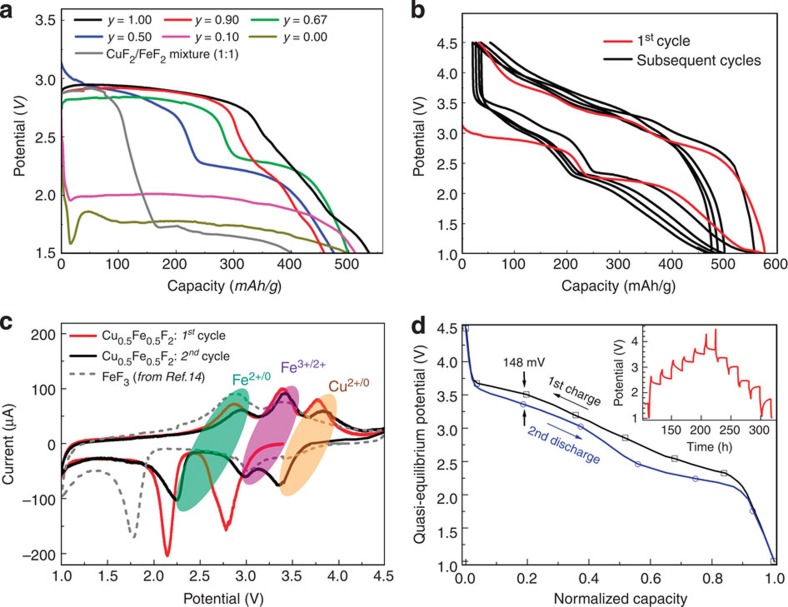
Electrochemical properties of CuyFe1-yF2 solid–solution.(a) Voltage profiles (first discharge at a current 5 mA g−1) of the CuyFe1-yF2 series along with a simple mixture of CuF2 and FeF2 (b) voltage profiles of Cu0.5Fe0.5F2 for the first five cycles (9.2 mA g−1), (c) cyclic voltammetry (CV) curves for the first (red) and second (black) cycles at a rate of C/40, in comparison to that of FeF3 (adapted from ref. 14), (d) quasi-equilibrium voltage profile from Cu0.5Fe0.5F2 obtained from galvanostatic intermittent titration technique (GITT) measurements (inset; 150 mA g−1 for 3.5 h followed by a 15 h rest). All the measurements were performed at room temperature.